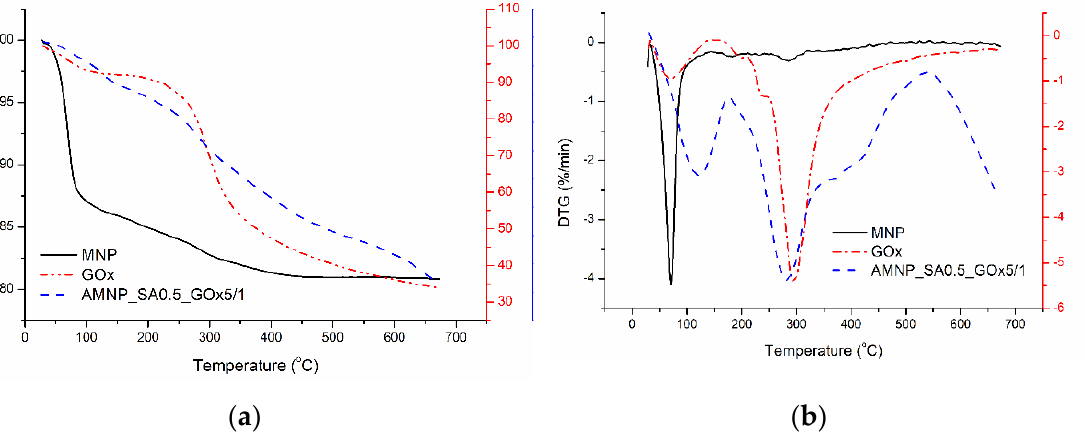
Figure 9. TG ( a ) and DTG ( b ) graphs corresponding to MNPs, enzyme (GOx) and amino-functionalized MNPs conjugated with enzyme via SA (AMNP_SA0.5_GOx5/1). Table 3. Parameters obtained from thermogravimetric analysis of simple and enzyme-coated nanoparticles. Sample Stage T onset T peak T